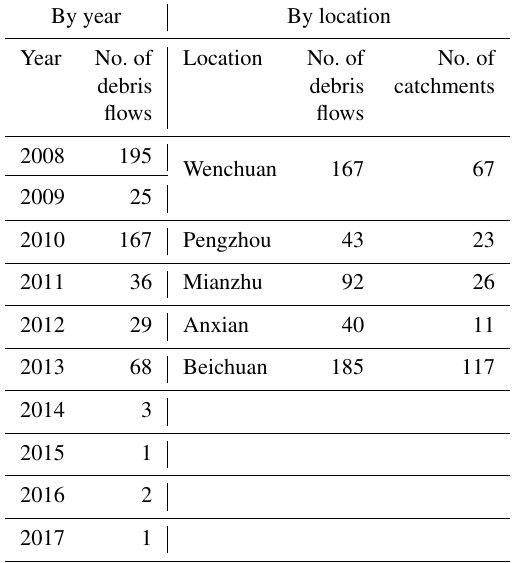
Table 8. Simple statistics of the debris flows and their triggering rainfalls recorded in the